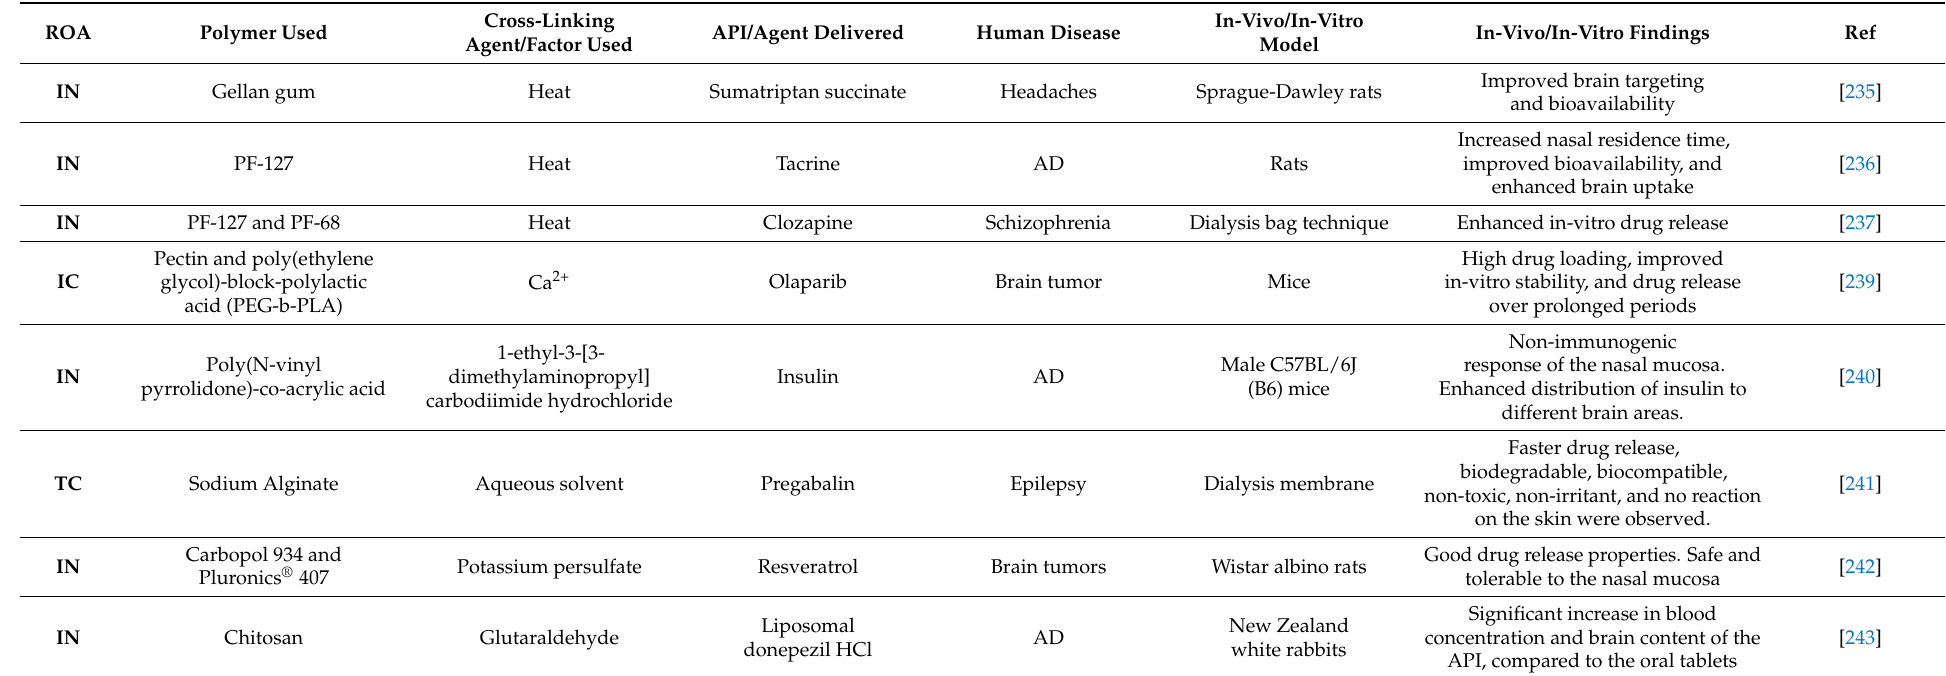
Table 5. Summary of non-injectable cross-linked gels in CNS